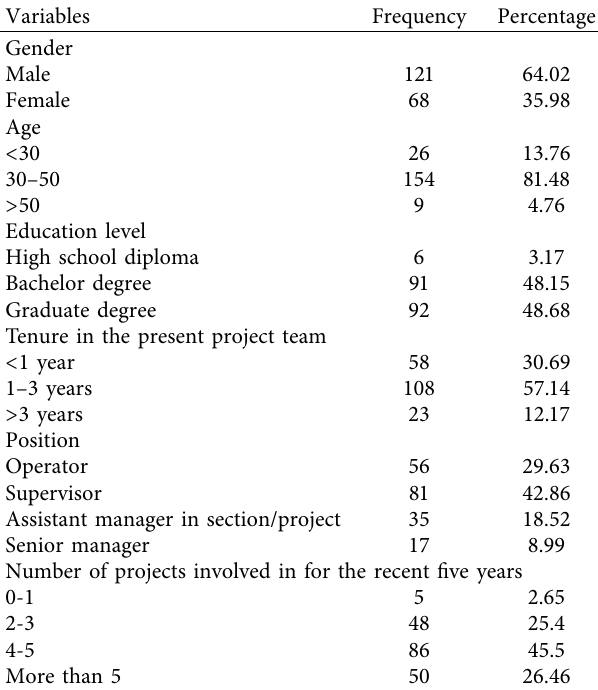
Table 1: Distribution of the respondents’